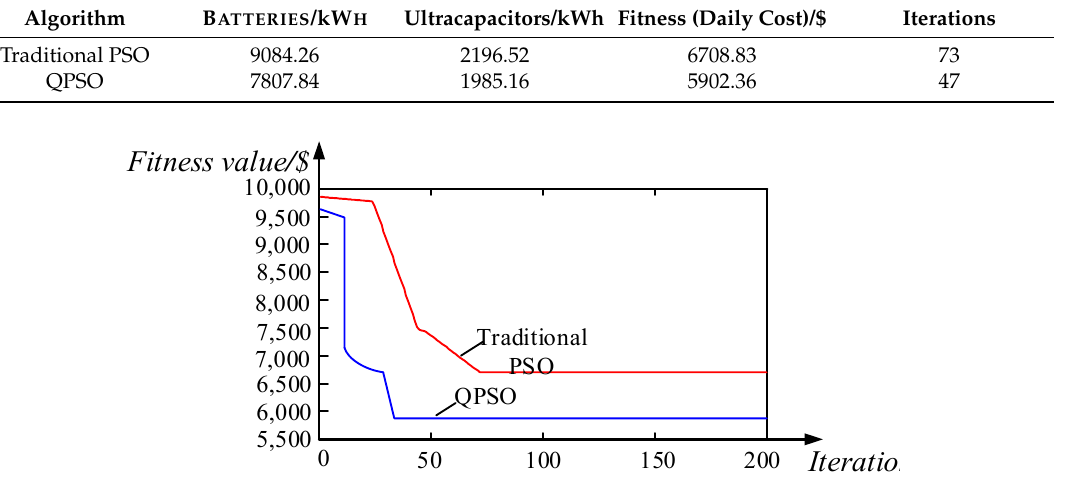
Figure 9. Comparison of optimization using two methods.